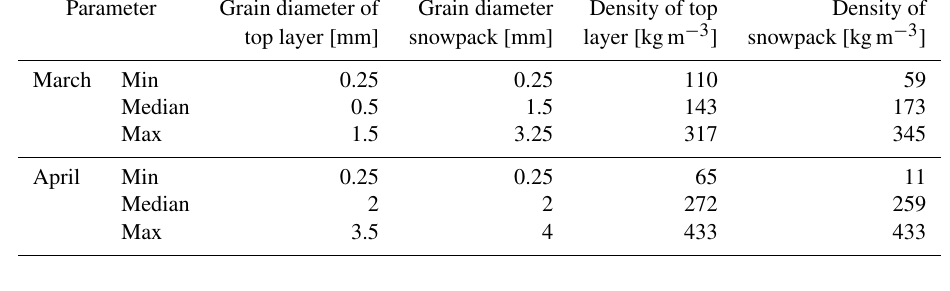
Table 2. The variation range and median values of snow grain size (defined as the maximum diameter of the smallest snow grain in each sam- ple) and density of the topmost layer and the snowpack during the SNORTEX campaign in Sodankylä in 11–19 March and 20–27 April 2009.